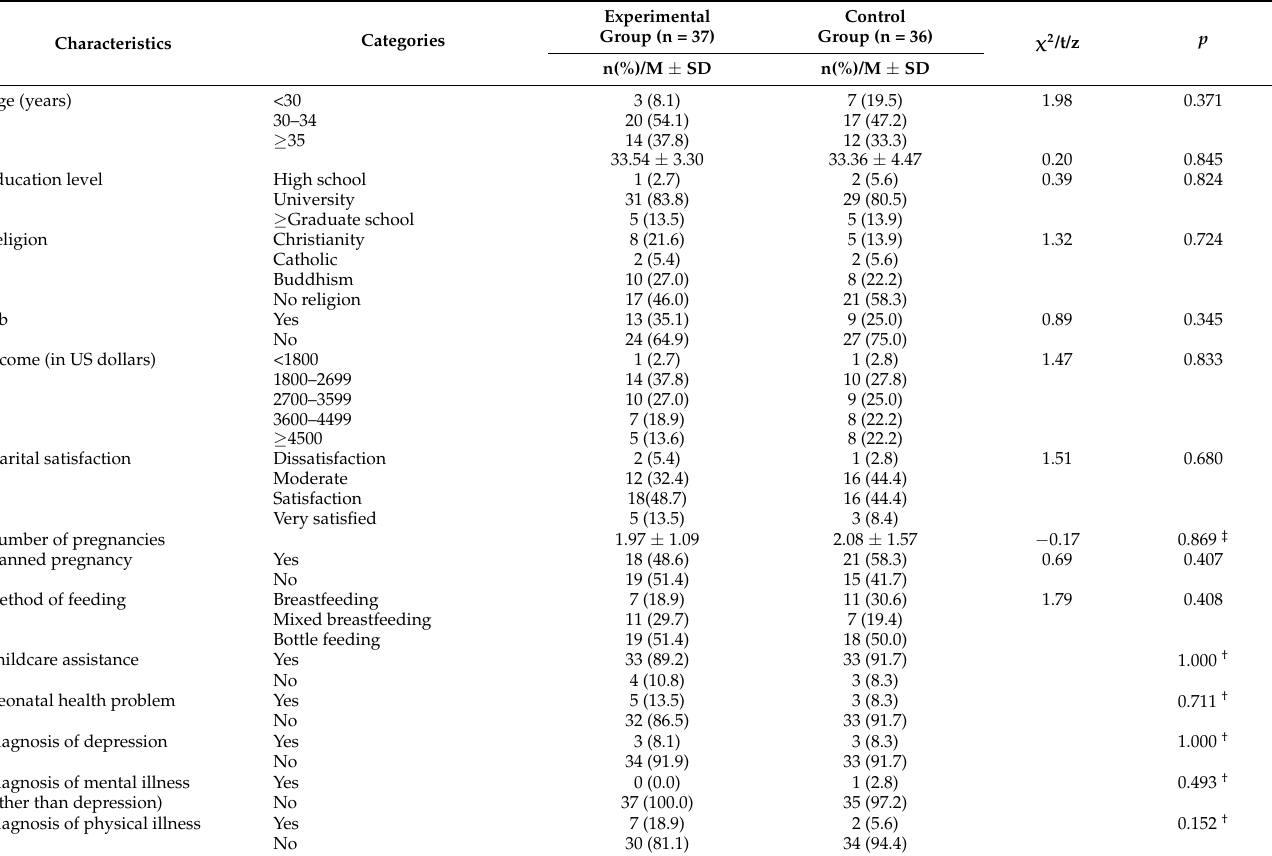
Table 1. Homogeneity Test for General Characteristics between Groups (N =